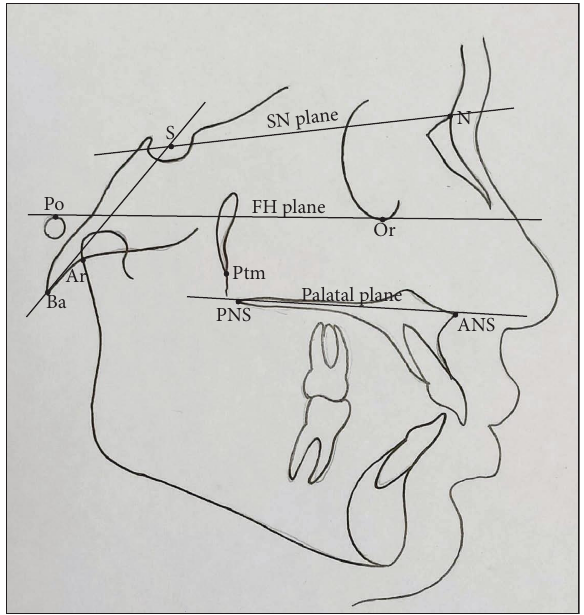
Figure 1: Cephalometric landmarks and reference planes. Land- marks: porion (Po), sella (S), nasion (N), basion (Ba), articulare (Ar), orbitale (Or), pterygomaxillary fssure (Ptm), anterior nasal spine (ANS), and posterior nasal spine (PNS). Reference planes: SN plane, the line joining S and N; FH plane, the line joining Po and Or; palatal plane, the line joining ANS and PNS; S-Ba plane, the line joining S and